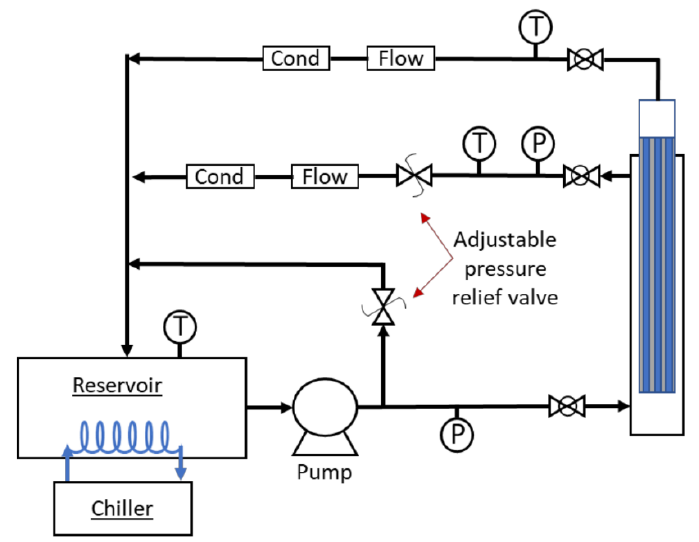
Figure 3. Simplified schematic of the RO test system: P = pressure transducer, T = K-type thermal couple, Flow = flow meter, and Cond = conductivity meter.